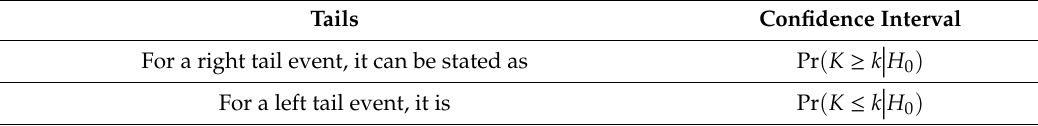
Table 6. Hypothesis testing: p -value logic.